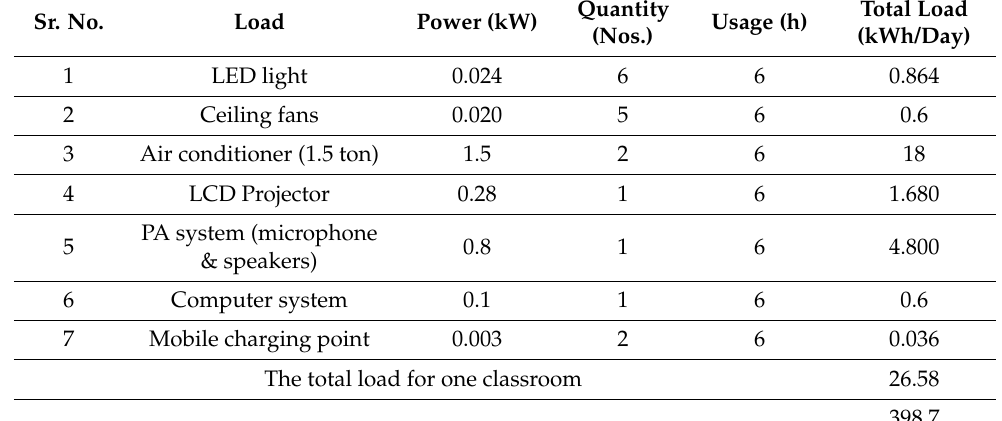
Table 3. Load estimation of 15 classrooms at SRM IST Delhi NCR campus.